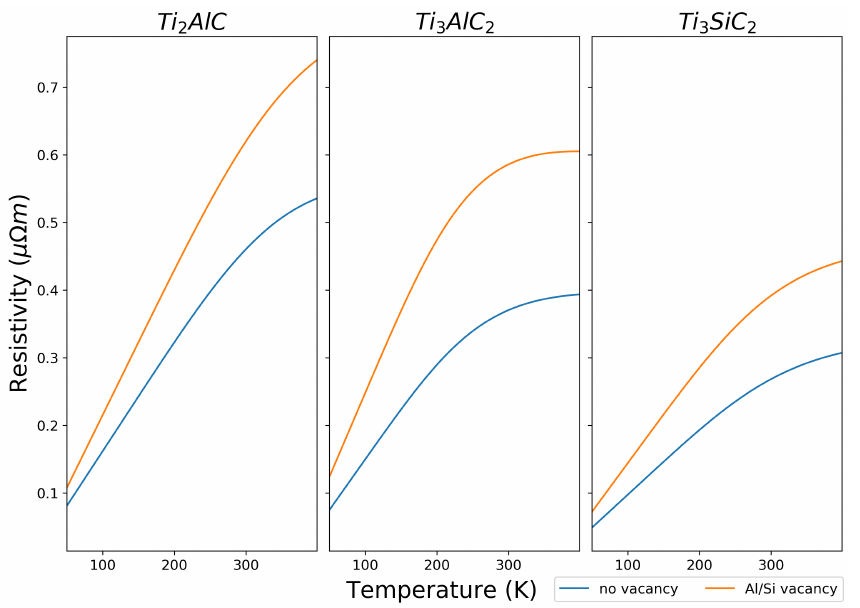
Figure 3. Resistivity of bulk MAX phases against temperature with and without an Al/Si vacancy from BoltzTraP2. Resistivities are taken at the chemical potential closest to zero, specifically at a values of µ − E f of 0.054eV and 0.058eV for Ti 2 AlC, − 0.024eV and − 0.036eV for Ti 3 AlC 2 without and with an Al vacancy, respectively, and 0.036eV and 0.022eV for Ti 3 SiC 2 , without and with a Si vacancy,